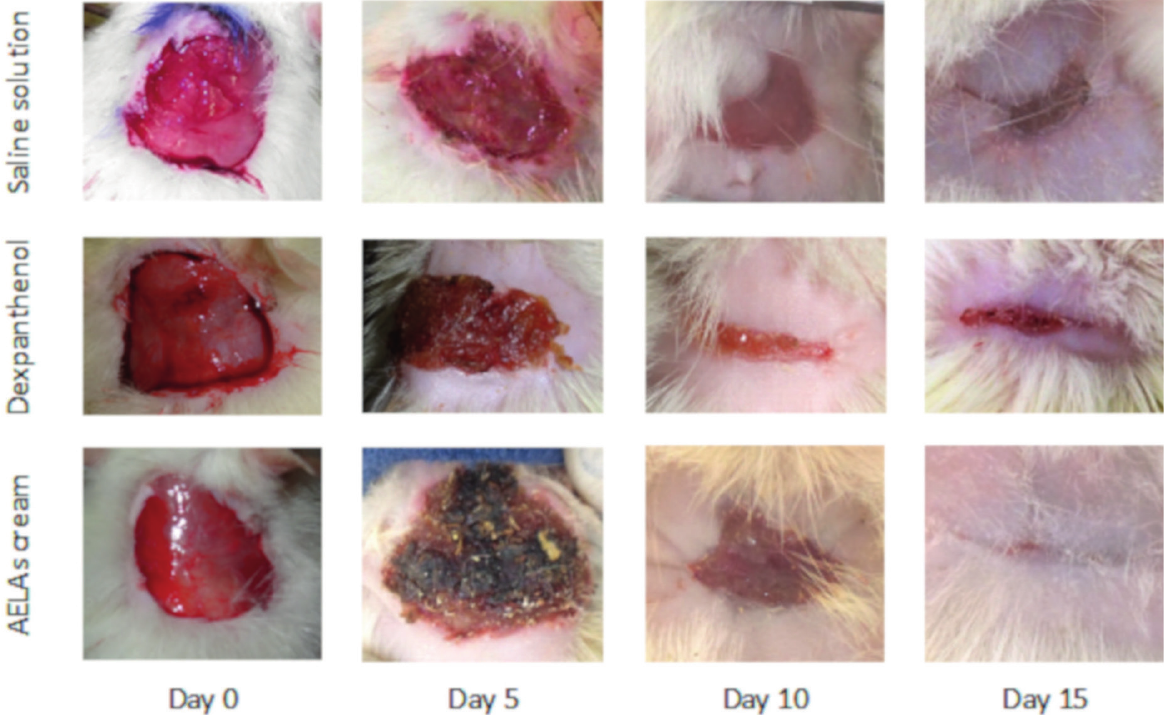
Figure 1 - Wound healing process in different days of